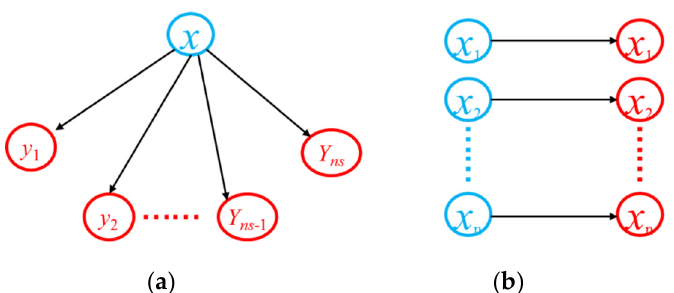
Figure 5. Comparison of the original problem and PH decomposition. ( a ) Original problem ( b ) PH Decomposition.